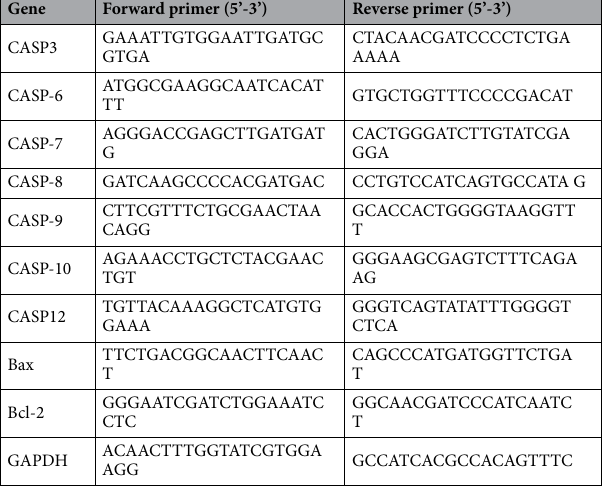
Table1. List of the